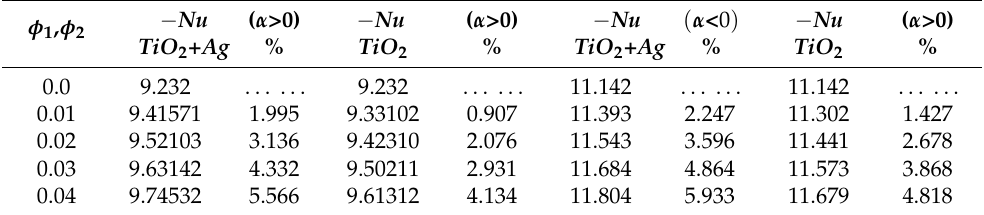
Table 7. Percentage augmentation in transmission rate of heat for augmenting values of volumetric